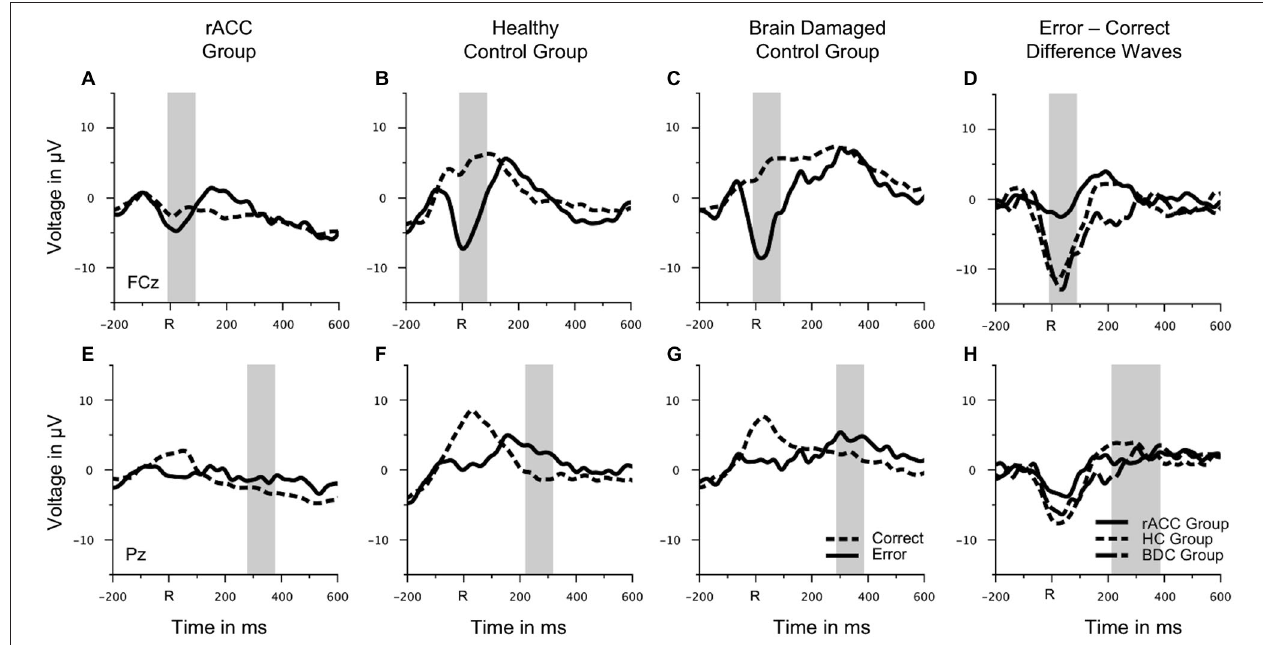
lesions of the rostral anterior cingulate cortex (rACC Group), in healthy controls (HC Group), and in patients with brain lesions outside the frontal lobes (BDC Group). R = time point of the button press; µ V = microvolt; shaded areas correspond to the time windows used for statistical analyses.